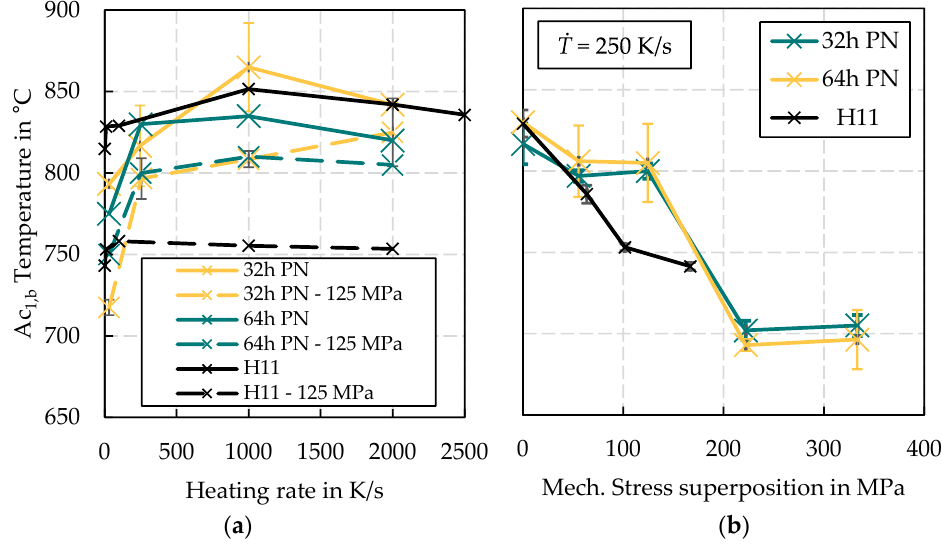
Figure 8. Results of the austenitisation tests: ( a ) Variation of heating rate, ( b ) Variation of mechanical stress superposition.